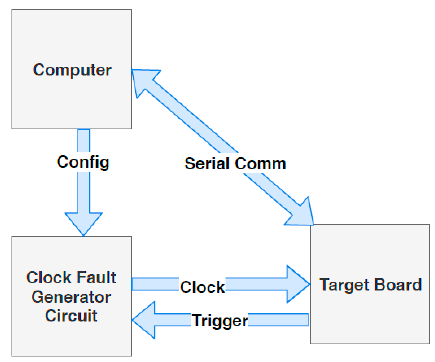
Figure 5. Experimental set-up of clock fault attack.